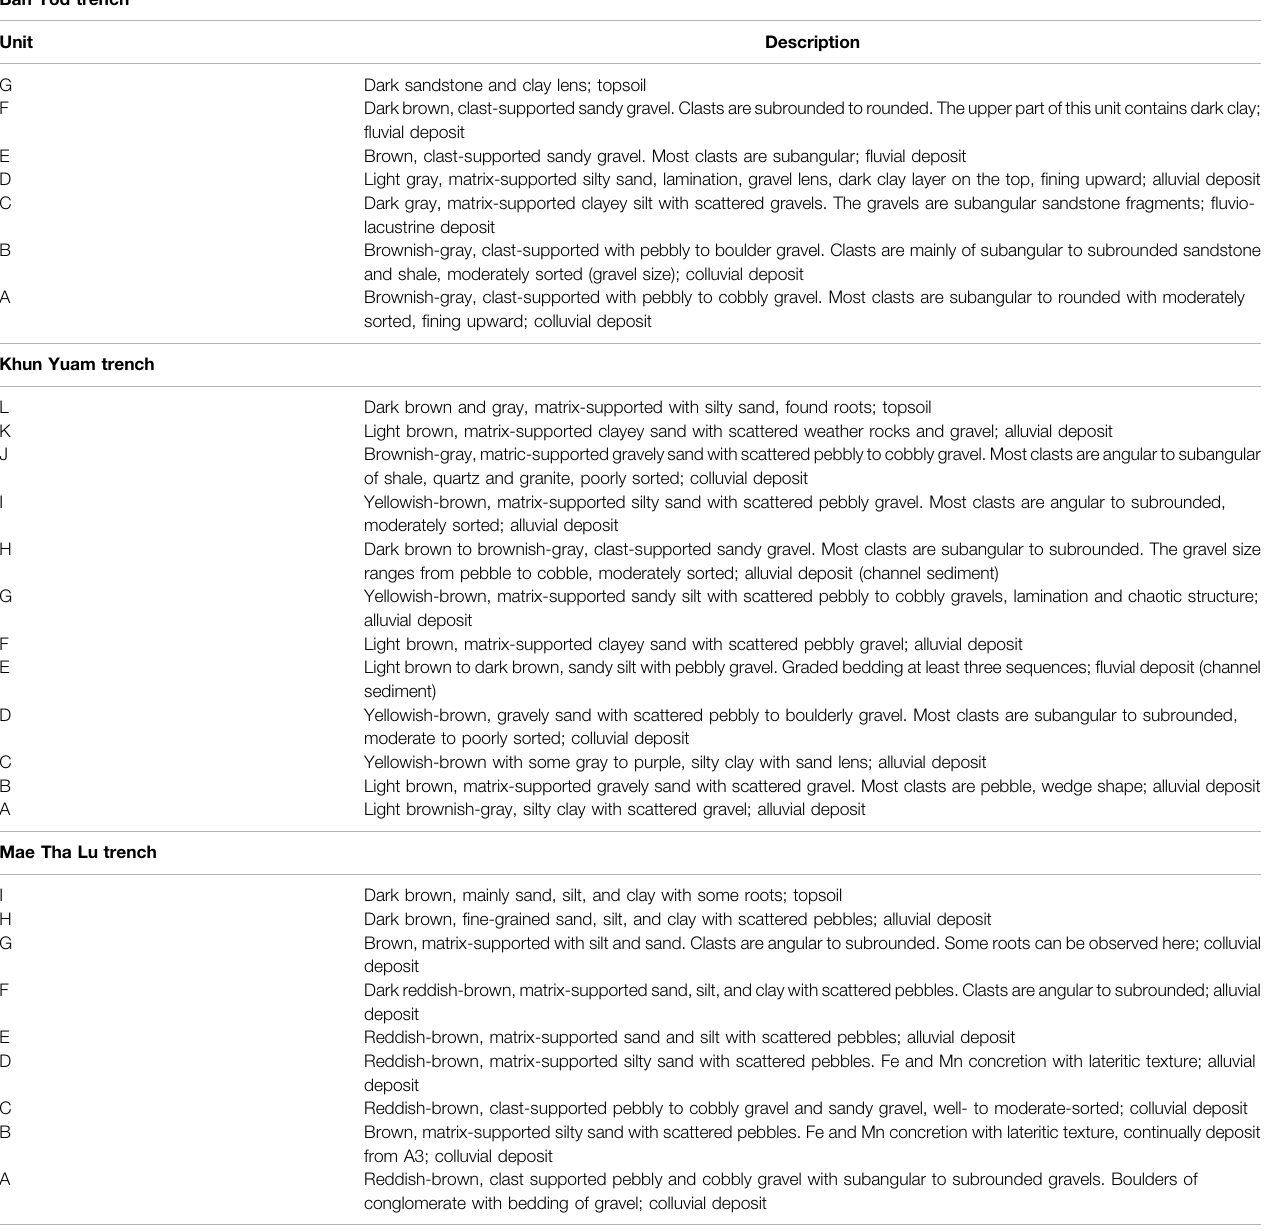
Table 2 provides radioisotope, water content, cosmic dose rate, DR and DE values, and OSL ages of each sample, with explanations of the methods used to calculate dose rates and age calculation uncertainties. Dose rate calculations follow the details highlighted in the table ’ s footnotes and are con fi rmed using the Dose Rate and Age Calculator (DRAC) of Durcan et al. (2015). The DR for all samples has